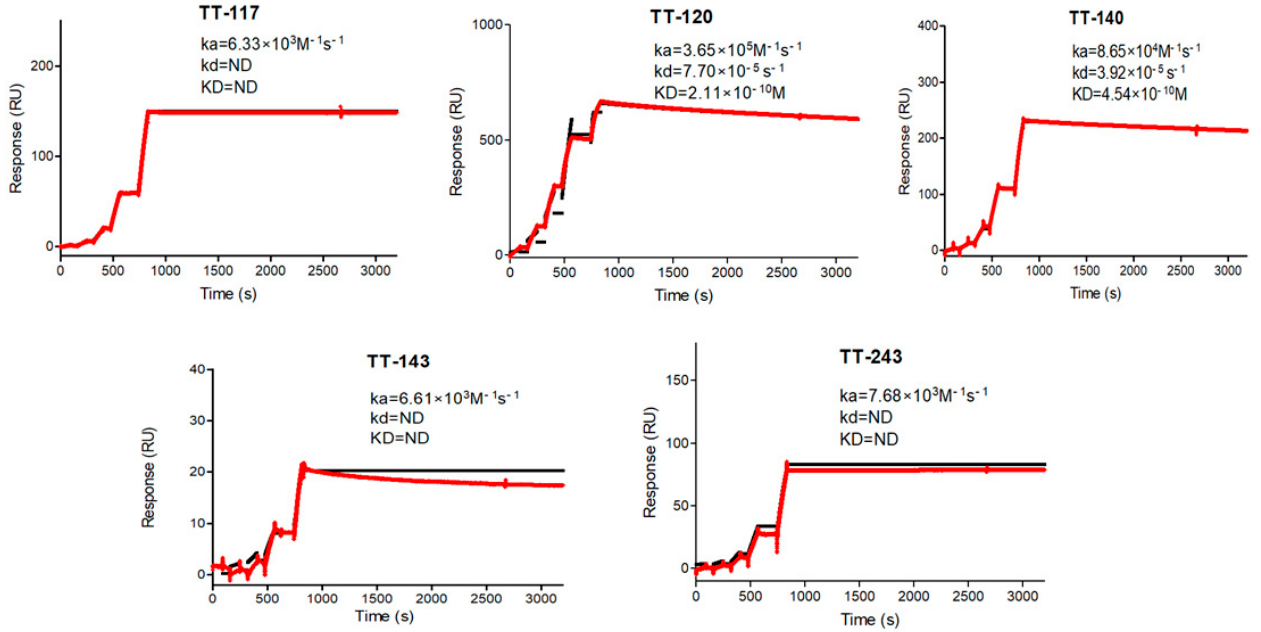
Figure 4. Binding affinity of anti-tetanus mAbs. Affinity constants were determined by single-cycle kinetics using Biacore T200 as described in the Materials and Methods. The red line represents the observed data, and the black line represents the fitted results in a Langmuir 1:1 model. ND = not determined: there was no dissociation in the period of 36,000 s. An increasing concentration of the analyte was applied without dissociation time between them. The graphs show the time up to 3000 s for better